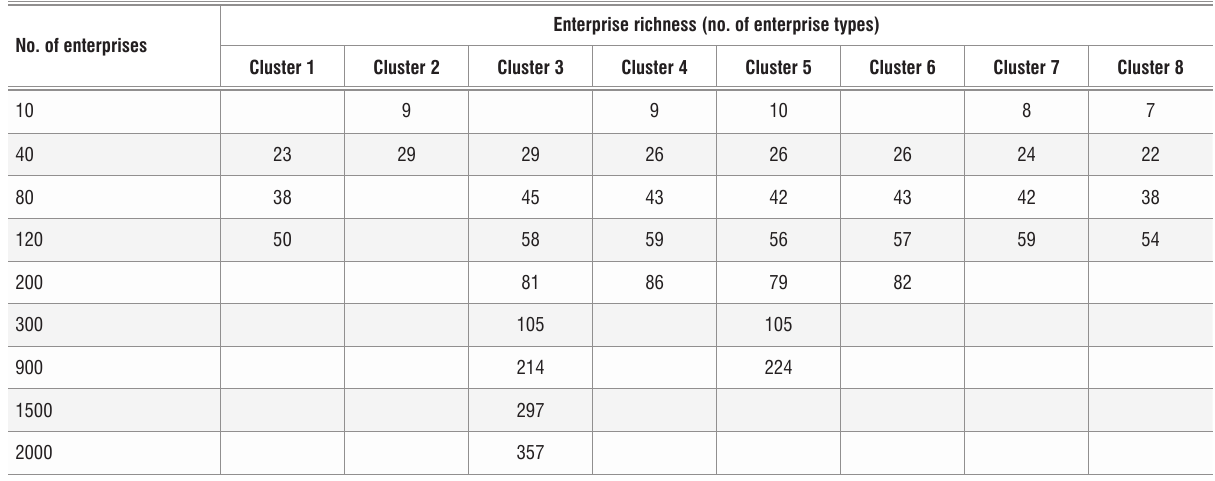
Table 7: Predictions of enterprise richness of the different town clusters at different enterprise numbers (predictions are limited to being close to the minimum and maximum enterprise numbers recorded in any town of a cluster)